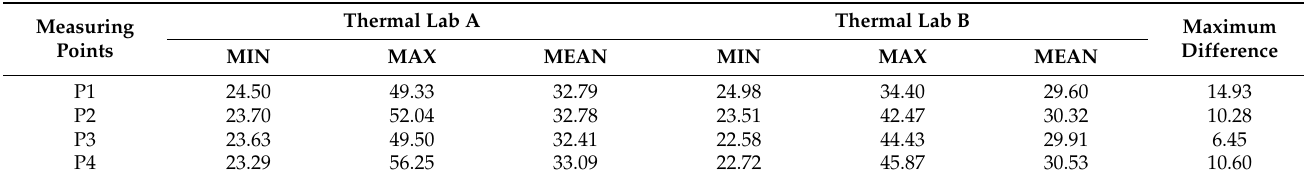
Table 9. Comparison of temperature measuring points in two rooms.